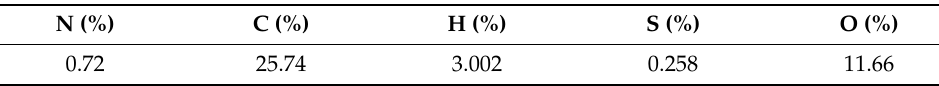
Figure 1. ( a ) ASR compositions, and ( b ) plastic composition of ASR [26,53–55]. Table 2. CHNSO analysis of